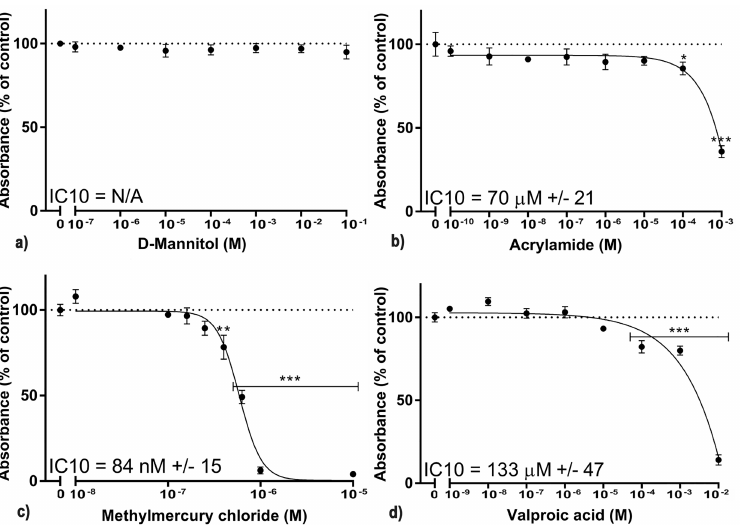
Fig 6. Cell viability of the C17.2 cells during exposure of a wide range of concentrations for four different compounds. The IC10 concentration was calculatedand was further used to validate proof of concept of the 30 selectedgenes. Cells exposedto a) D-mannitol(negativecontrol) b) acrylamide c) methylmercury chlorided) valproicacid sodium salt. The data are presentedas the mean of 3 independent experiments preformed in hexaplicates. Results were analyzedusing two-way ANOVA followedby Dunnett’s multiplecomparisons test. The bars represent the mean ± SEM. * p (cid:20) 0.05, ** p (cid:20) 0.01, *** p (cid:20) 0.001 comparedto control (cells exposedto only cell medium). The inhibitoryconcentration 10% (IC10) was determined from nonlinearregression to fit the data to the log(inhibitor) vs response(variableslope) curve using the Hill slope (slope factor), equation Y = Bottom + (Top-Bottom)/(1+10^((LogIC10-X) * HillSlope)) (GraphPad Prism 7.02).